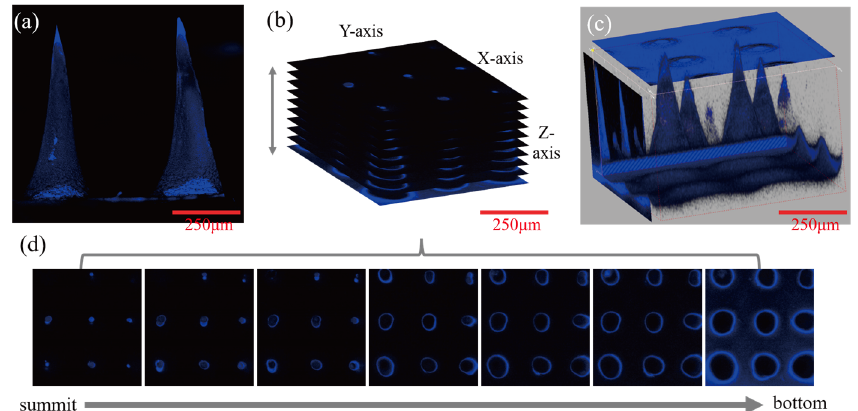
Figure 10. Confocal laser microscopy photos of the 20/1/100 microneedle: ( a ) CLSM images of single-layer scanning when the body of melatonin microneedle was parallel to the objective lens; ( b ) z-axis continuous rotation (x: 306.5 ◦ , y: 301.3 ◦ , z: 57.6 ◦ ) vertical accumulation; ( c ) 3D synthetic images of melatonin microneedles under CLSM; ( d ) CLSM images of the xy-plane in the z-axis series when the tip of the melatonin microneedle is facing the objective lens. (Scale bar is 250 μm).